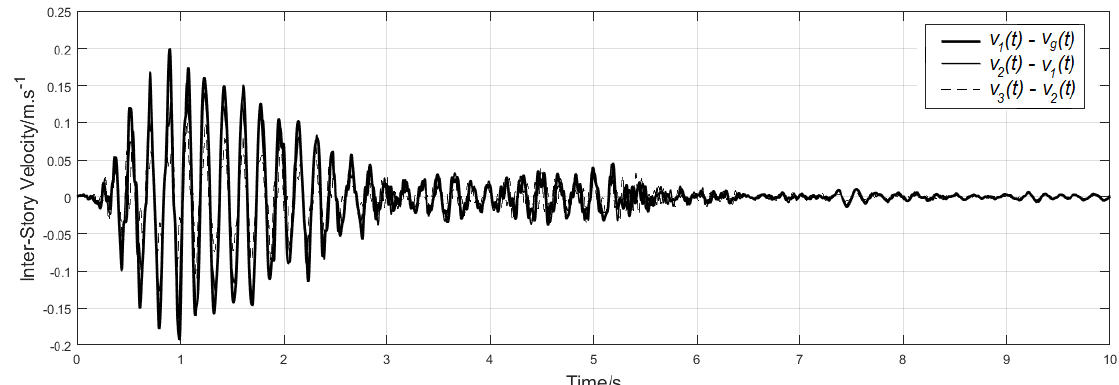
Figure 7. The relative velocity of the structure, without MR damper, when excited with the earthquake signal.